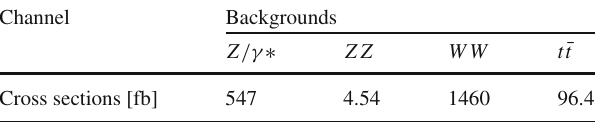
Table 3 Background processes and their cross sections. In Z /γ ∗ and Z Z events, only the Z boson decay to b ¯ b is considered, while for WW and t ¯ t , the fully hadronic decay is produced by forcing the W boson to decay to all quark pairs Channel Backgrounds Z /γ ∗ Cross sections